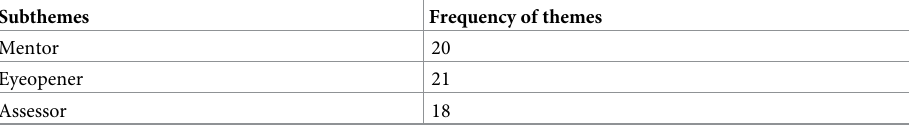
Table 6. Subthemes of interpreting trainers’